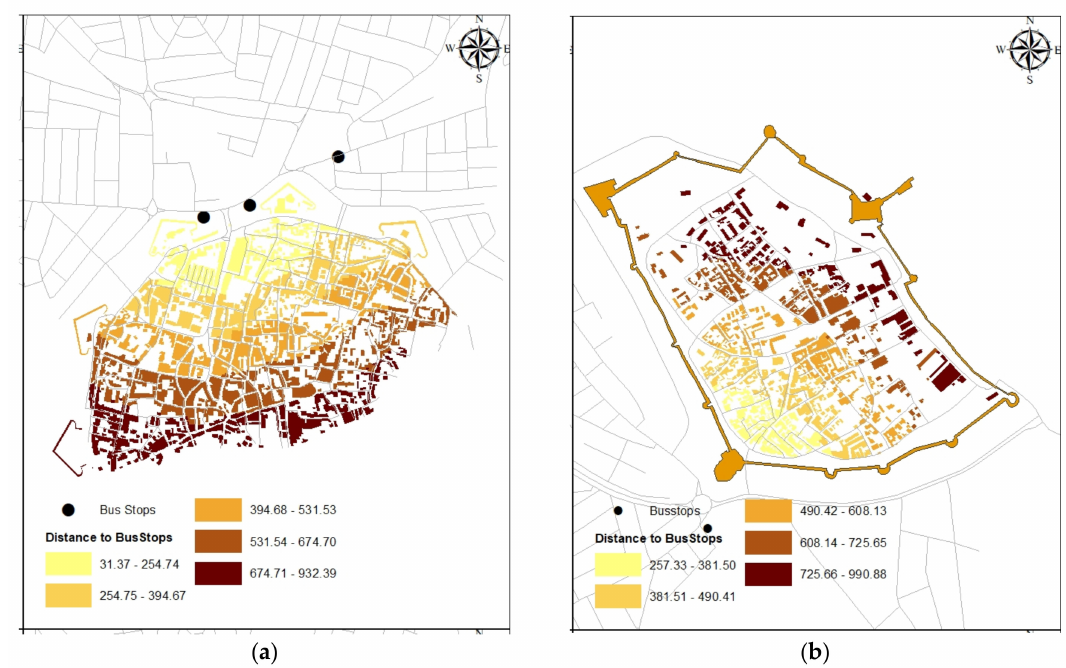
Figure 6. Accessibility to Bus Stops in Nicosia ( a ) and Famagusta ( b ) Walled